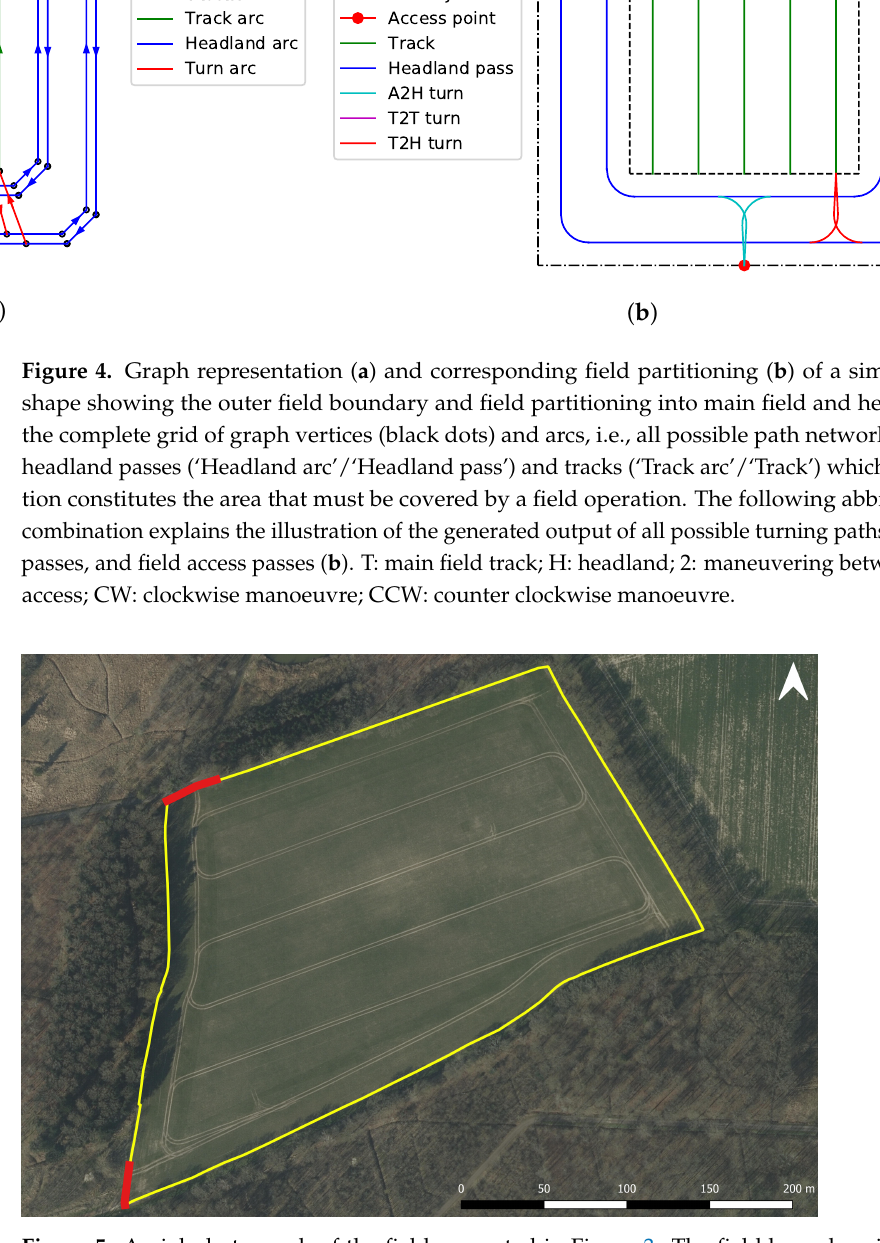
Figure 5. Aerial photograph of the field presented in Figure 3. The field boundary is marked in yellow and field entry/exit segments are marked in red. There are five visible main field traffic lanes and the headland traffic lane is also visible. The field traffic lanes are oriented in the same direction as defined for the field partitioning as illustrated in in Figure